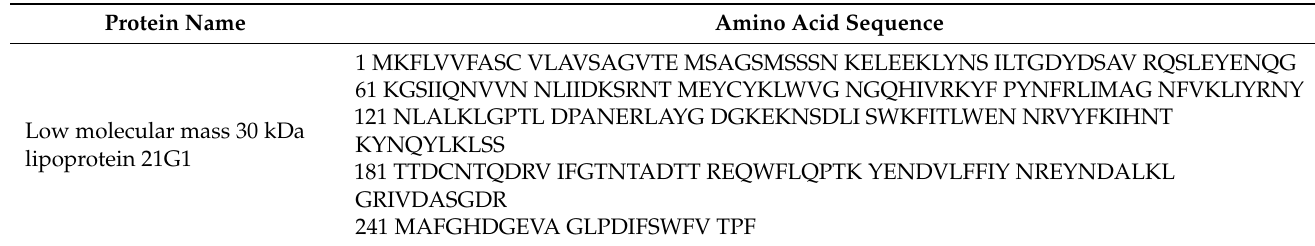
Table 2. Amino acid sequence of Low molecular mass 30 kDa lipoprotein